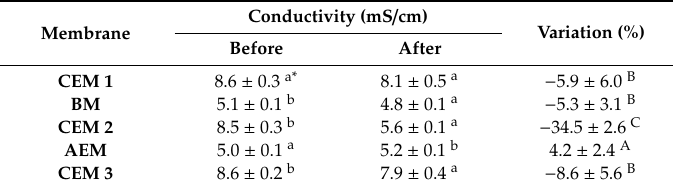
Table 1. Membrane conductivity before and after electrodialysis with bipolar membrane (EDBM) treatment regardless of the temperature used (placed in the same order as stacked in the system configuration).